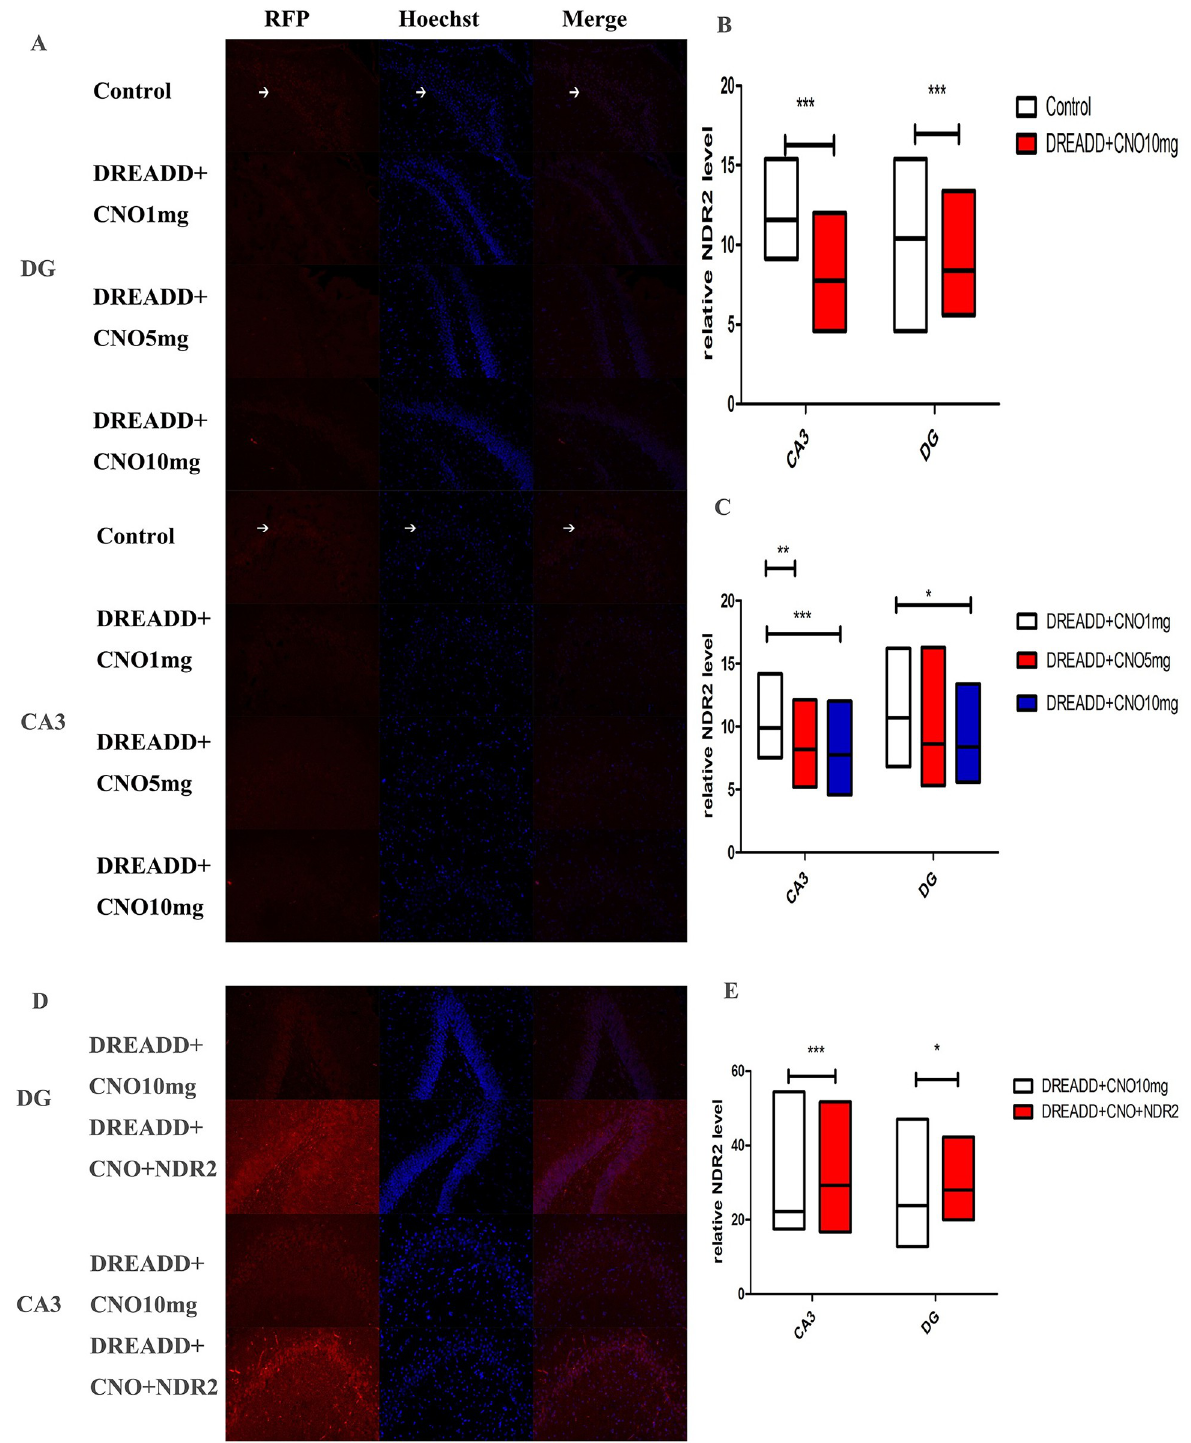
Fig 5. The NDR2 levels in the control, DREADD+CNO and DREADD+CNO+NDR2 groups were measured by immunofluorescence. A and D, Representative fluorescence pictures of the CA3 and DG are displayed; B, the level of NDR2 in the DG and CA3 of the hippocampus were down- regulated in DREADD+CNO group(n = 5) compared with that of control group(n = 5, Mann-Whitney test); C, Comparing NDR2 levels in CA3 and DG in DREADD rats treated with 1 mg/kg CNO(n = 4), decreased NDR2 in CA3 was observed in DREADD rats treated with 5 and 10 mg/kg CNO(n = 4 and 5 respectively), and decreased NDR2 in DG was observed in DREADD rats treated with 10 mg/kg CNO(Kruskal-Wallis test);E, The